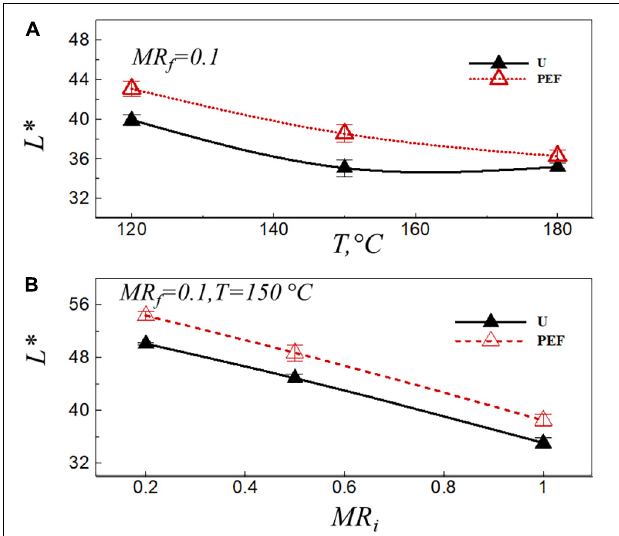
FIGURE 5 | Oil uptake, O f , vs. the frying temperature (A) and the moisture ratio after VD, MR v (B) for U and PEF pre-treated samples. All samples were fried to MR f = 0.1 ( p <